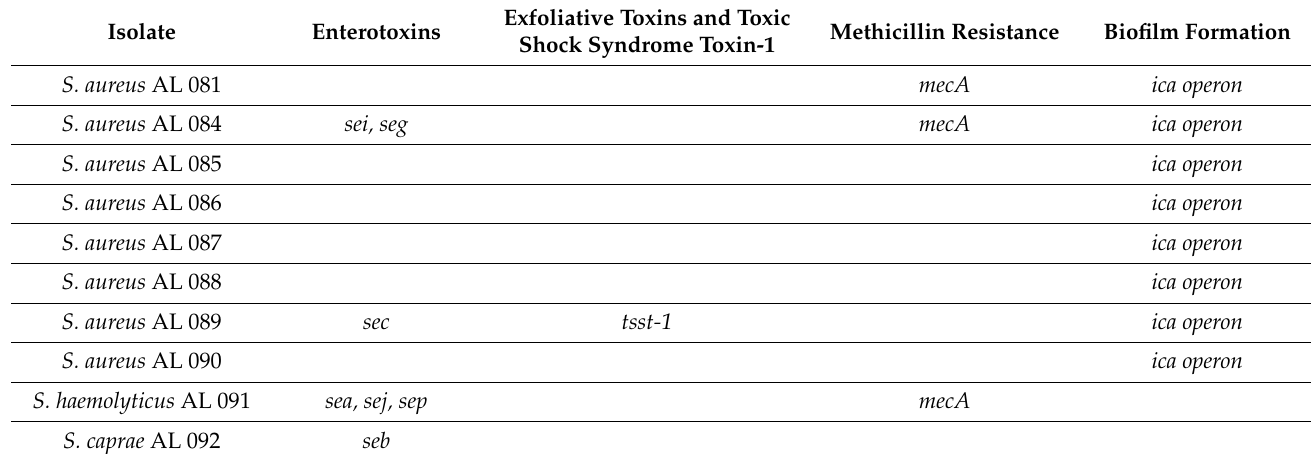
Table 3. Distribution of genes among Staphylococcus spp.